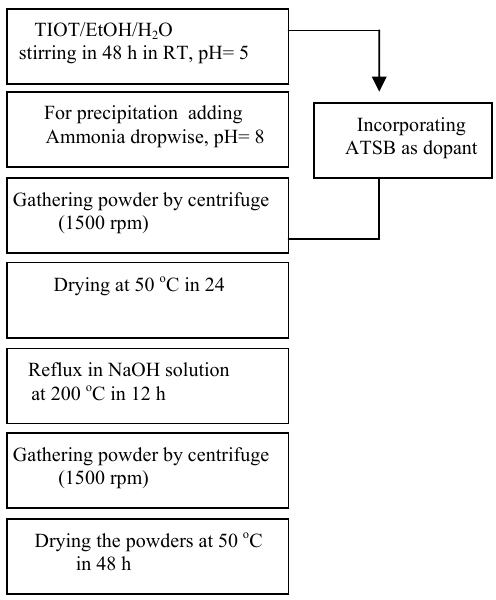
Fig. 1. Schematic flowchart illustrating the steps in the synthesis pathway of TiO nanorods. 2 Table 1. Composition of starting solutions